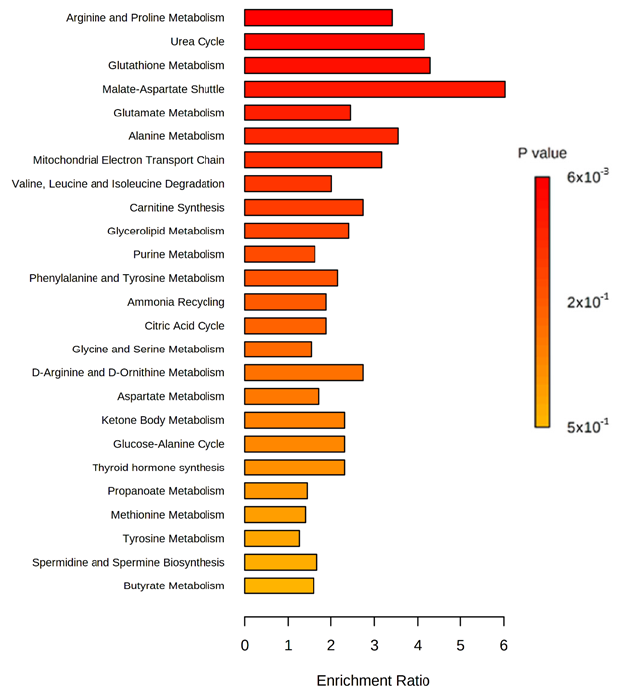
Figure 3. Pathway enrichment analysis of the differential metabolites in cecal samples of dextran sulfate sodium (DSS)-induced colitis mice receiving water with or without alpha-ketoglutarate.